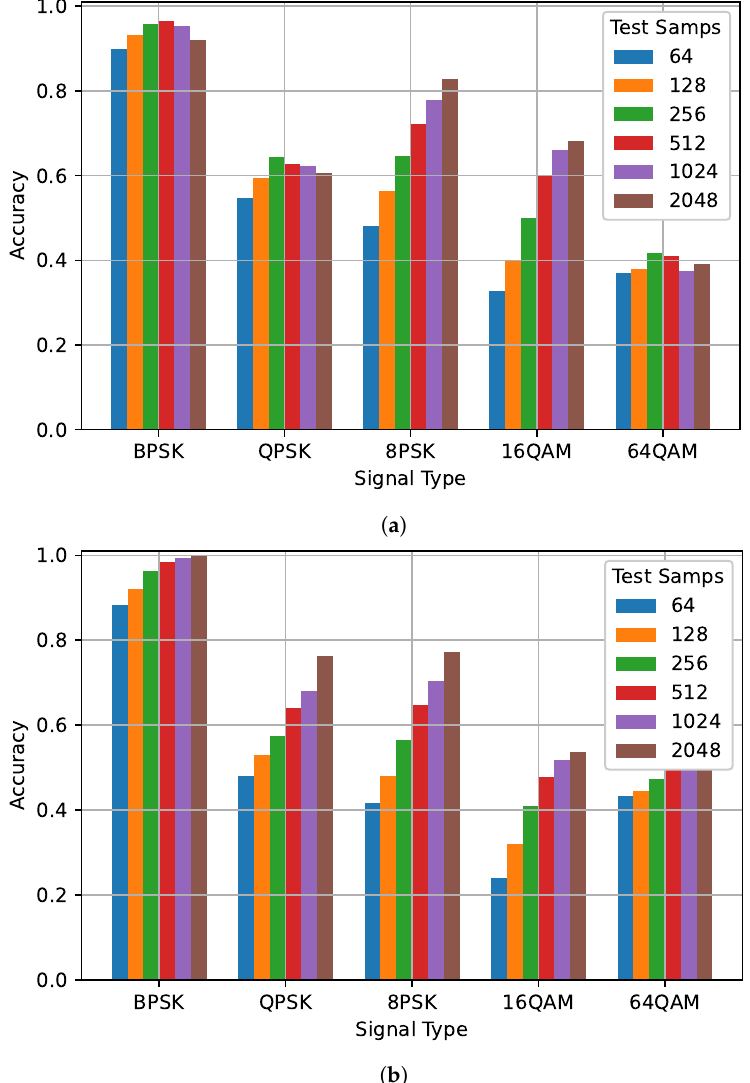
Figure 4. The impact of different training and testing sequence lengths on performance for different modulations on the best network trained on ( a ) 128 samples and ( b ) The impact of 1024 samples. Sequence lengths of 64, 128, 256, 512, 1024, and 2048 were tested for both